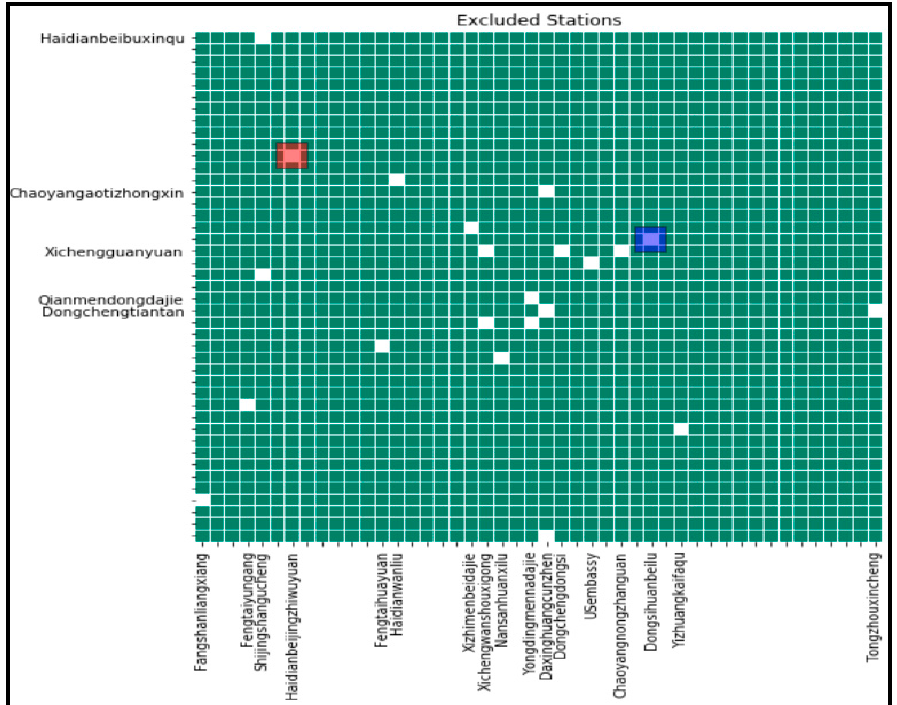
Figure 7. Generalization performance evaluation. The red and blue squares are the stations that will be estimated.